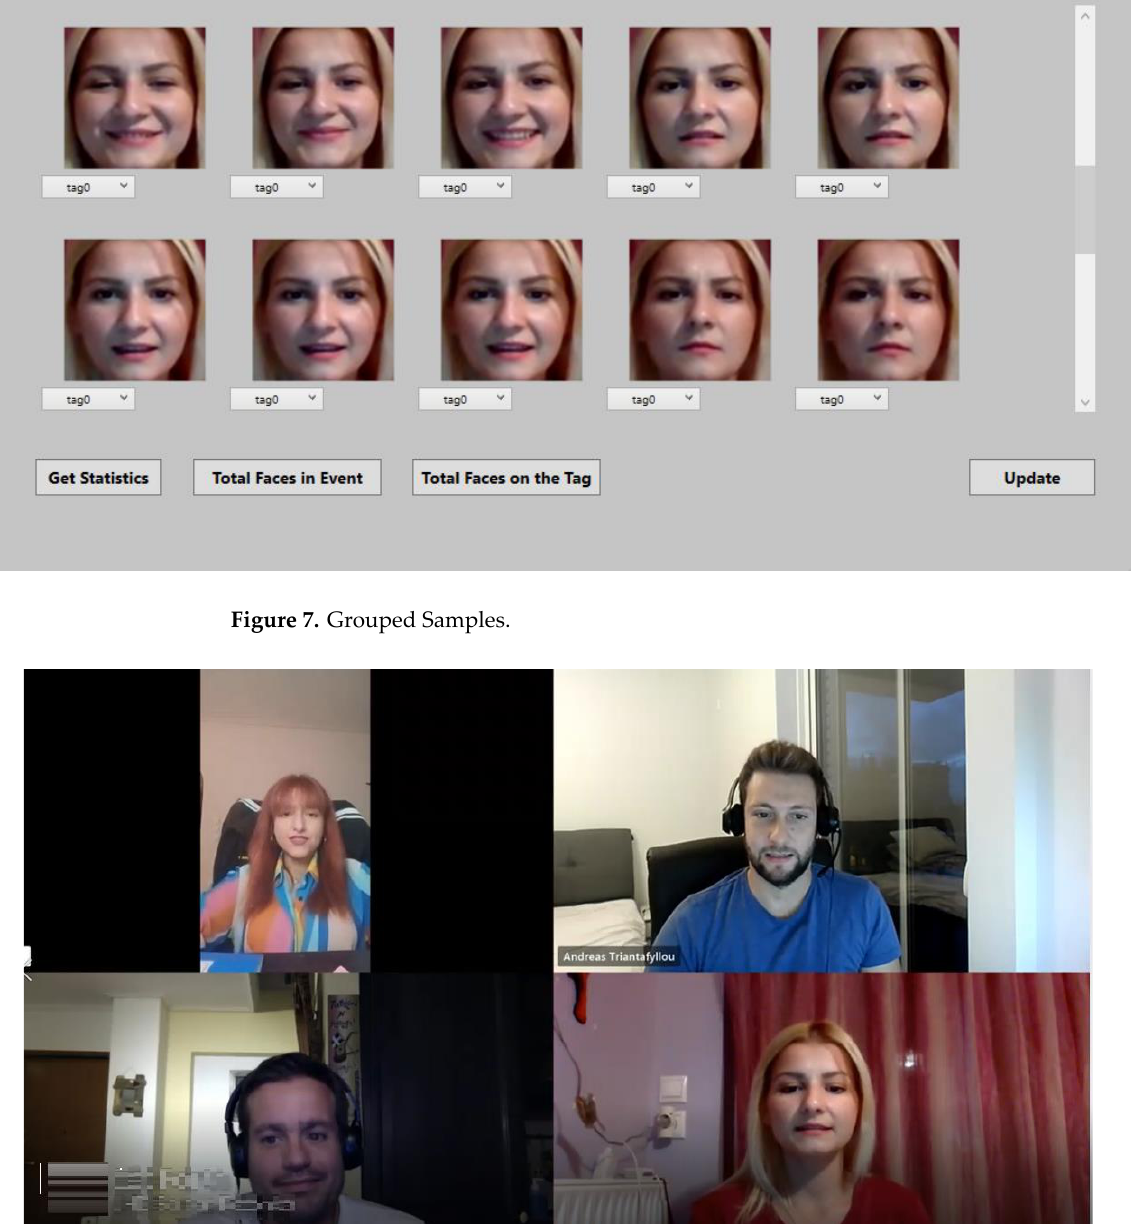
Figure 9. Selected Training Set. 6. Evaluations After the completion of experimental activities, we proceed to the evaluation section. In particular, we used the recorded video for Scenario 1, and we evaluated the three new algorithms for group concentration value calculation. The three algorithms have been run for the entire duration of the video, with each measurement taken at the same point in time for all algorithms. Here we can see the group concentration values per algorithm for all states of Table 3. As we can observe in Table 4 and Figure 10, the second algorithm with time weights exhibits sharper shifts for group concentration values because the time when a student is or is not paying attention to the lesson carries more weight than the random times with a lack of concentration. Furthermore, we notice that, when using the third algorithm, the concentration values change more intensely at the moments that each Group Window is full, and the values “are held” by the group for some samples/period (Group Time Win- dow) (Figure 11) as we mentioned earlier in the algorithms section.